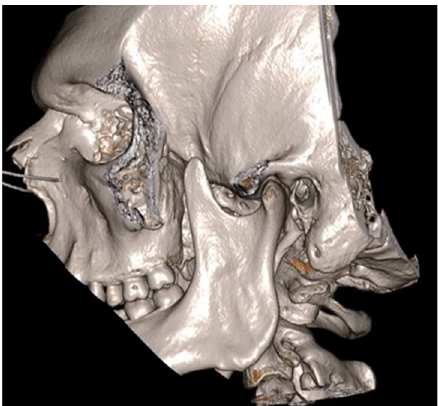
Figure 7. 3D CT reconstructions showing an enlarged left CPM.